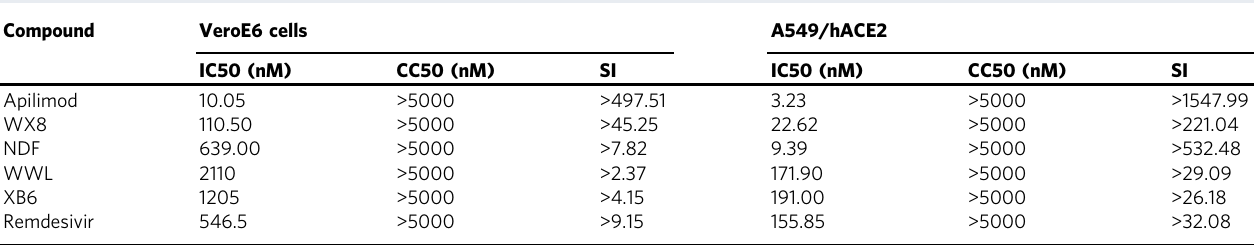
Table 1 In vitro ef fi cacy data for PIKfyve inhibitors against SARS-CoV-2 in VeroE6 and A549/hACE2 cells. Compound VeroE6